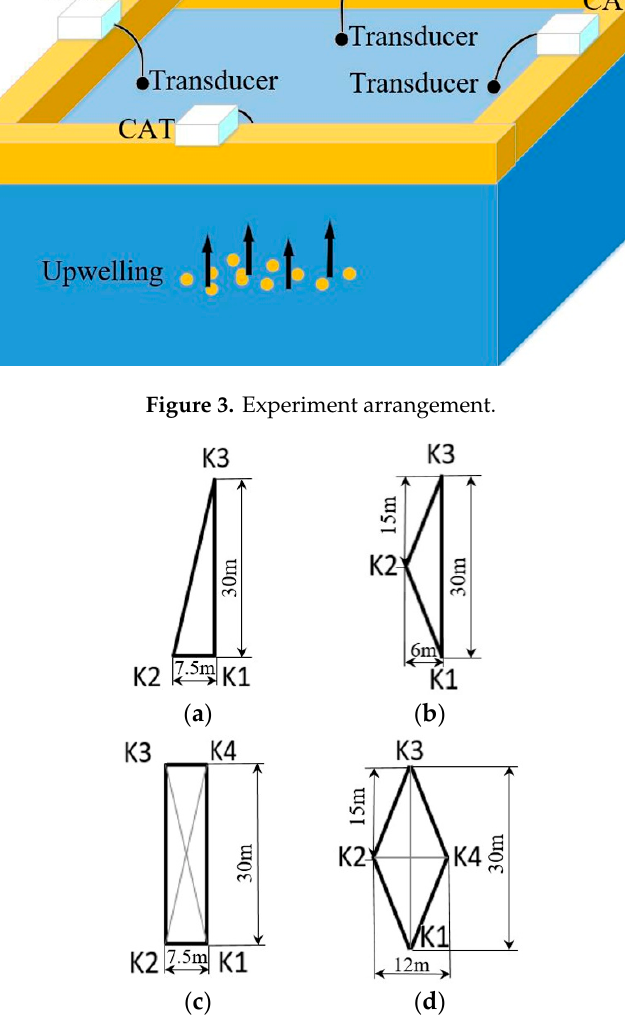
Figure 3. Experiment arrangement.